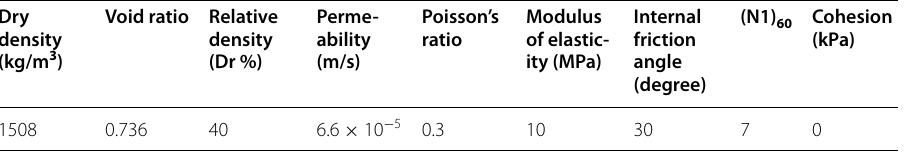
Table 1 Characteristics of Nevada sand with relative density 40% [22] Dry